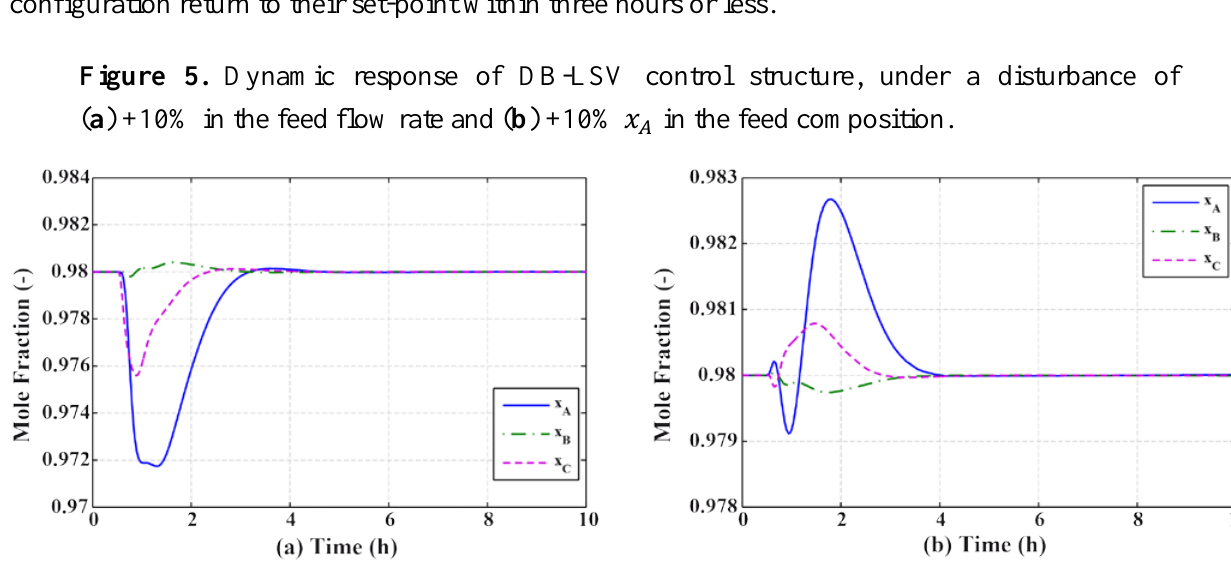
Figure 6. Dynamic response of DV-LSB control structure, under a disturbance of ( a ) +10% in the feed flow rate and ( b ) +10%